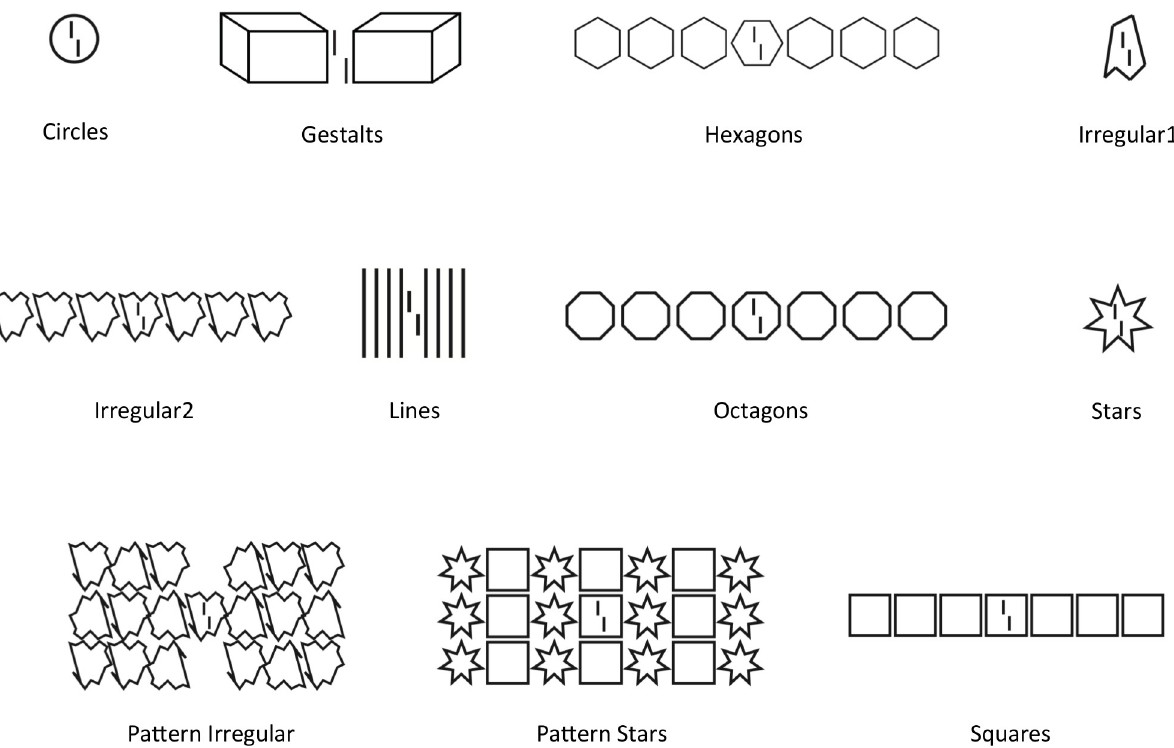
Fig 4. Stimulus categories. We used 40 different stimuli from 11 different categories. The task was always to report the offset direction of the central vernier. This figure shows one example from each category. The stimulus database is tailored to test for global effects such as uncrowding. Human data was taken from previous work [10,11,15,17,19,20].Human and model results are summarized in the discussion (Fig 14 shows the results for all stimuli and models).